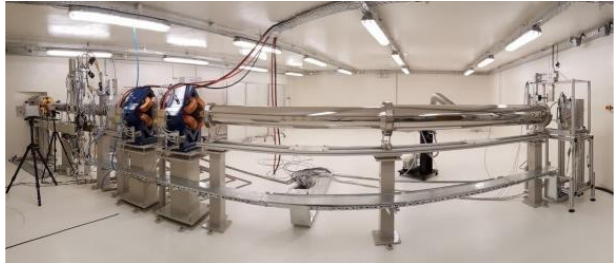
Fig. 8. Panoramic photo of the preliminary test design. The beam comes from the accelerator from beamline in the left wall. Initial beam diagnostics are made with CCD camera which looks at the image of the beam on an Al2O3 screen. The test and measurement system at the target area measures the flux and uniformity of the beam with 3 movable detectors. There is a beam dump before the beam hits the right wall. The total length of pretest line of METU- DBL is 6.97 m.